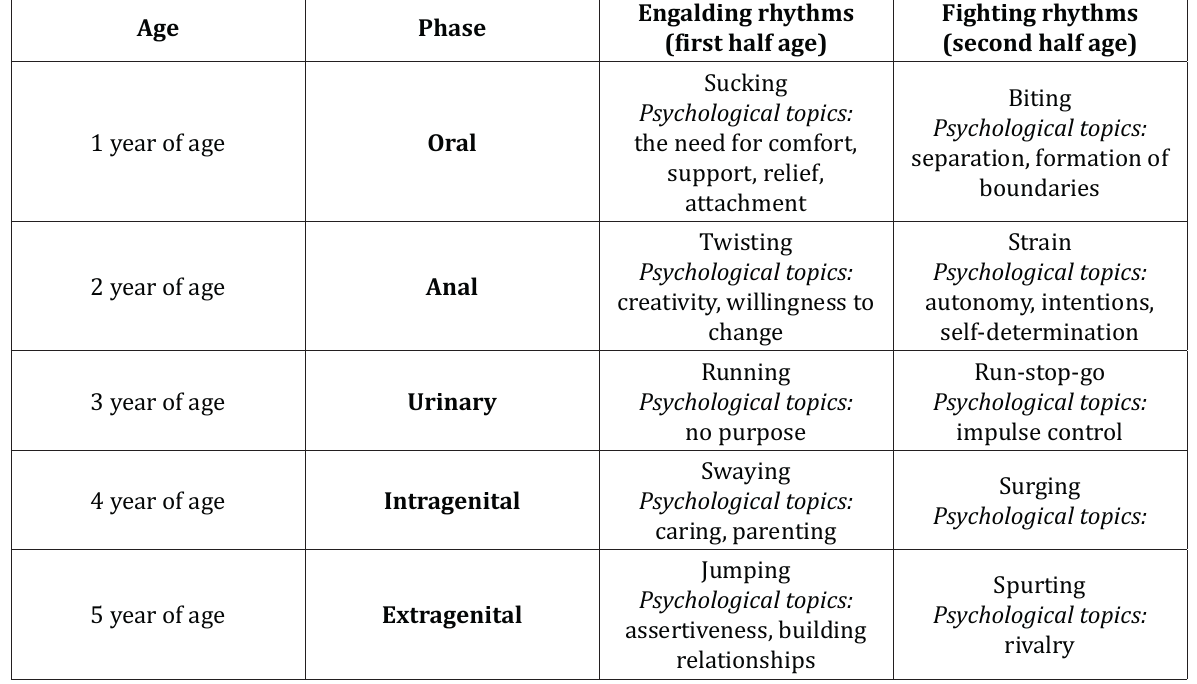
Table 4. Developmental rhythms (source: own elaboration based on [44])